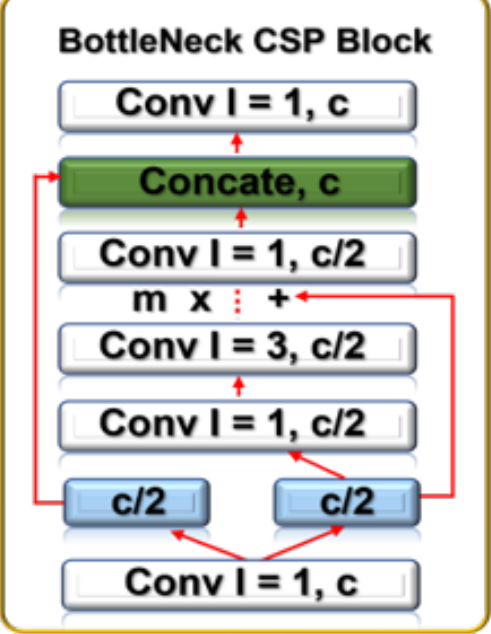
Figure 5. BottleNeck CSP block showing its constituent convolution